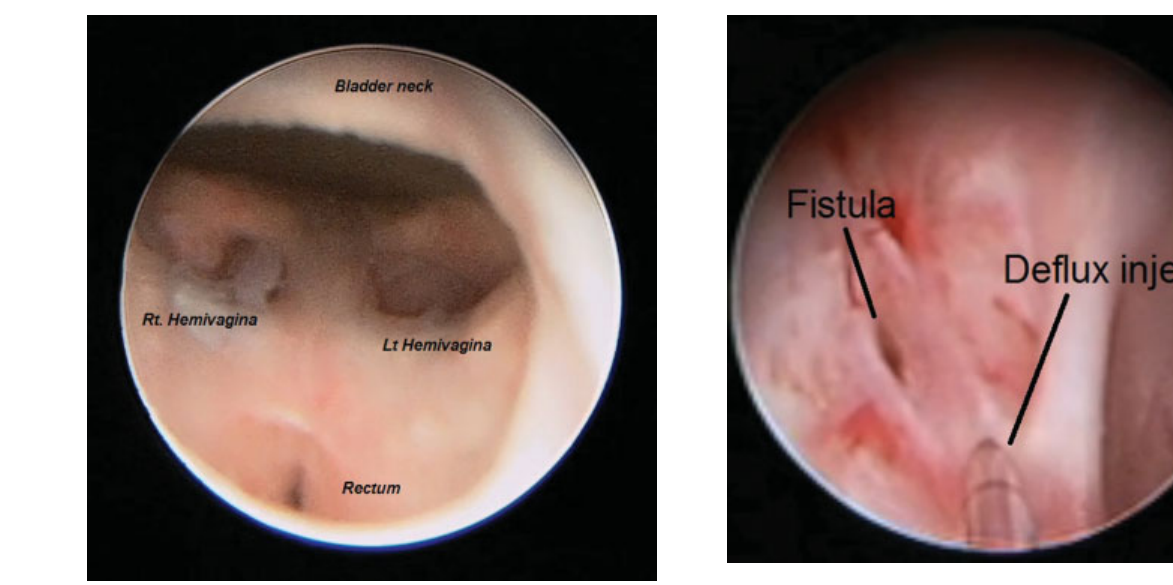
Fig. 3 Cystoscopy view at the second day of life.